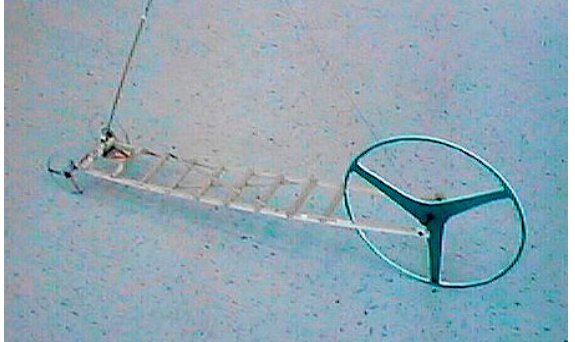
Figure A2. Mouse trap #2.